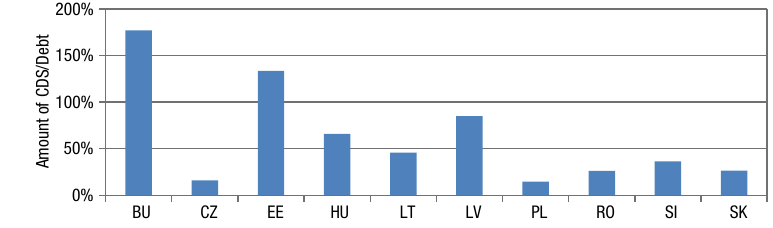
Fig. 2. Outstanding gross notional amount of CDS with respect to the sovereign debt on 26 April